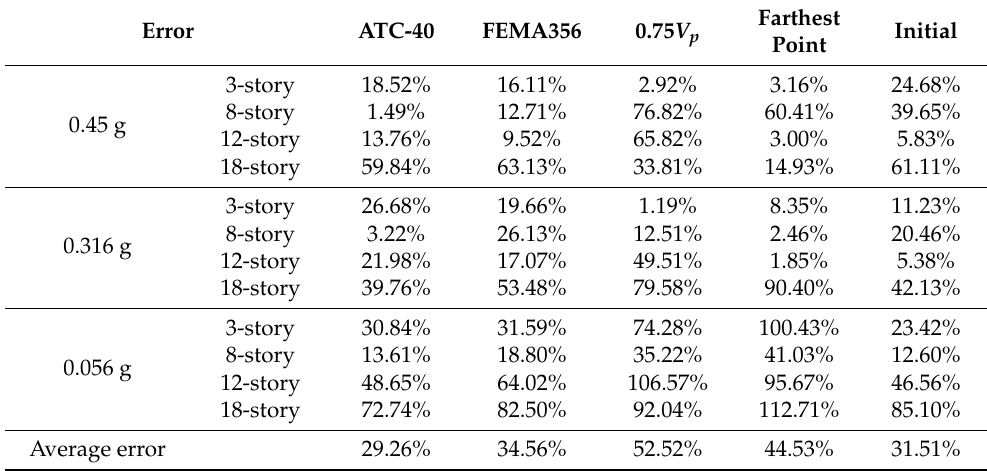
Table 4. Errors of calculated inter-story drift ratios (maximum value within all the stories).